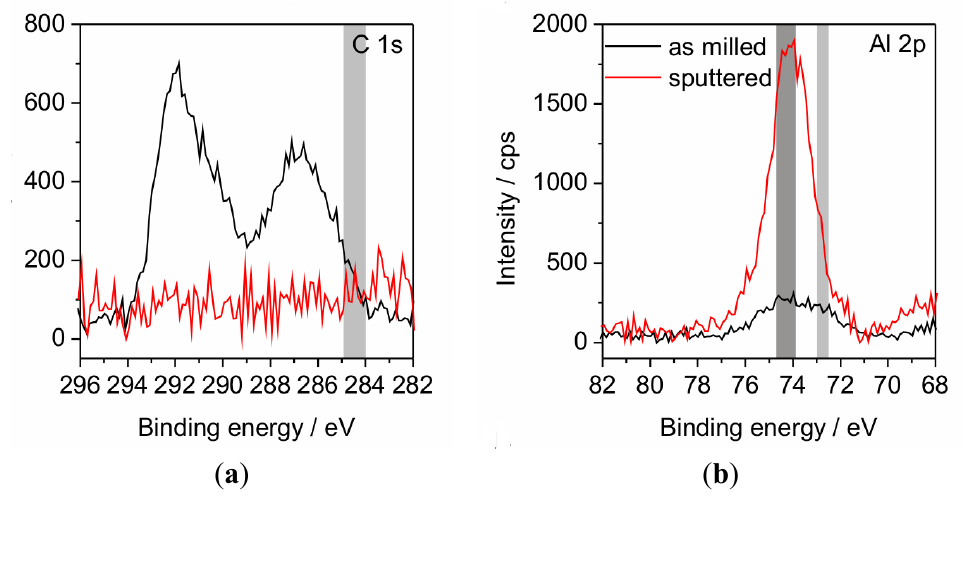
Figure 4. XPS diagrams of powder P1 including the binding energy lines of the elements C ( a ), Al ( b ), Li ( C ), Y ( d ), Ni ( e ), O ( f ) and Fe ( g ). The grey areas mark the theoretic energy ranges as referenced by Moulder et al. [24]. The right, light grey areas indicate the position of the elemental line; left positioned, dark grey areas indicate oxide states.